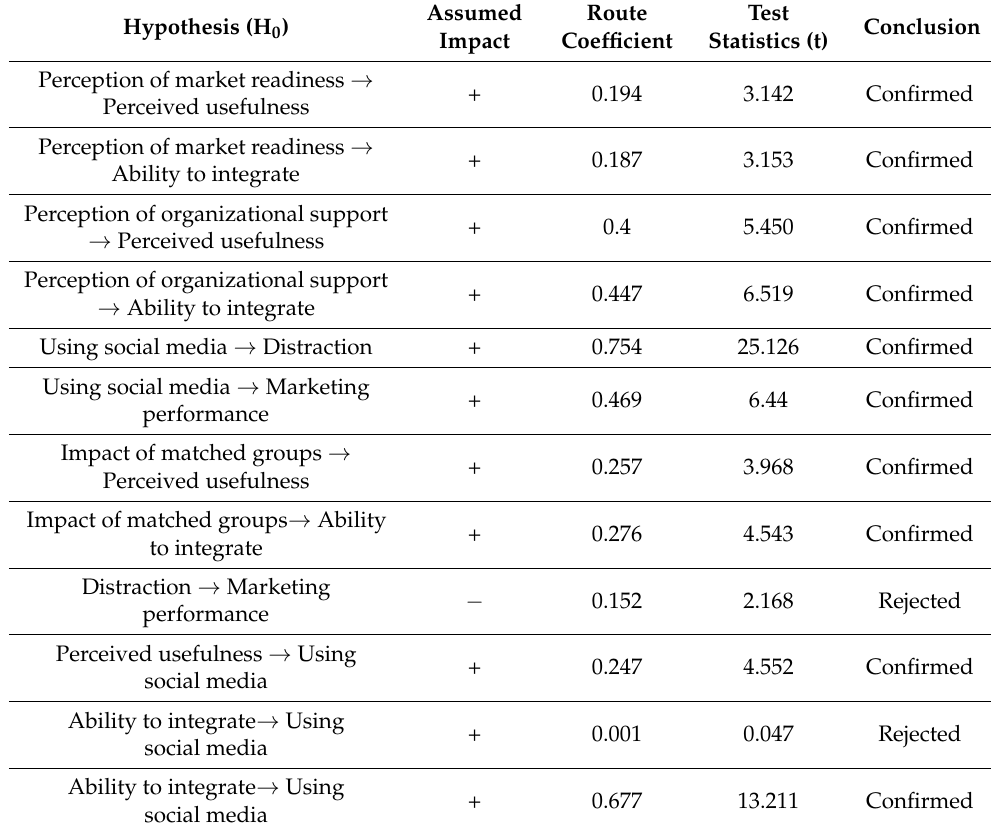
Table 9. Results of the structural equation